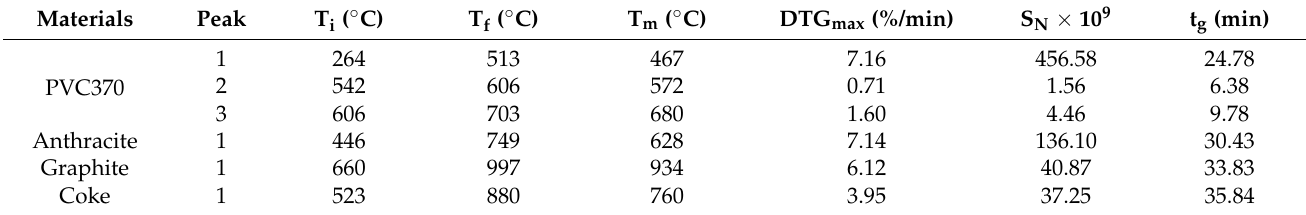
Table 4. Combustion characteristic parameters of different samples.